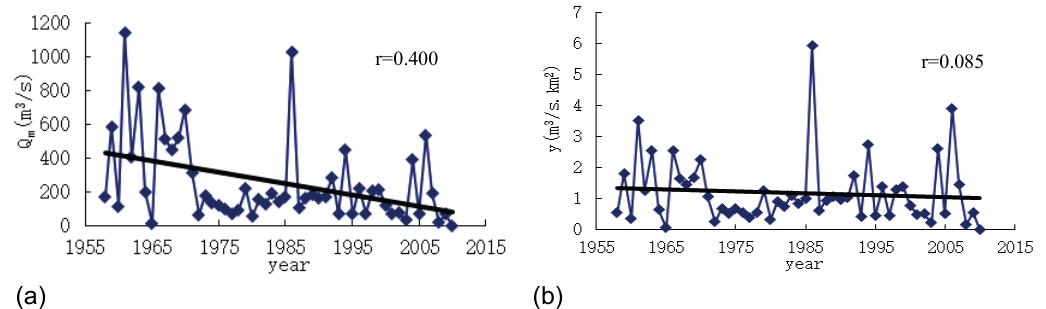
Fig. 2 (a) Trend of Q m at Dianshi Station. (b) Trend of Y series at Dianshi